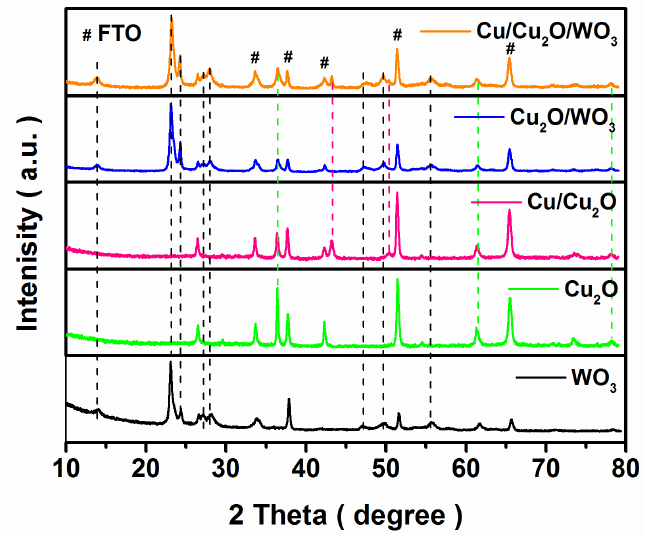
Figure 1. XRD patterns of the bare and composite samples (# sign: the characteristic peak of FTO substrate). X-ray photoelectron spectroscopy (XPS) measurements were carried out to elucidate the surface composition and chemical states of the elements. The survey XPS spectrum of the typical Cu/Cu 2 O/WO 3 sample indicated that the composite mainly consisted of W, Cu and O electrons. To gain further insight into the chemical bonding between W and other atoms in the composite, the high resolution XPS spectrum of W 4f (Figure 2a) was decon- voluted by Gaussian-Lorenzian analysis. The peaks at binding energies of 37.7 and 35.7 eV were ascribed to W (VI) state in tungsten oxide materials, while two distinct peaks at 34.5 and 36.4 eV were consistent with the values of W (V) oxidation state for all the sam- ples [42,43]. The existence of W (V) was necessary to maintain the opening structure of hexagonal WO 3 [14]. However, the area ratios of W (V) and W (VI) in the composite were higher than those of the bare WO 3 sample (Table S1) due to the electroreduction process for Cu 2 O deposition. In the high-resolution Cu 2p XPS spectrum (Figure 2b), two conspic- uous peaks were observed at binding energies of 952.3 eV for Cu (I) 2p 1/2 and 932.5 eV for Cu(I) 2p 3/2 [44]. Furthermore, the Cu and W diffraction peaks of the composite shifted slightly compared with those of pure samples, which was the reason that the intense in- teraction existed between WO 3 and Cu 2 O component in the composites, implying the for- mation of heterojunction. Cu LMM Auger spectra (Figure 2c) were further performed to explore the chemical state of the Cu element, The Auger parameter can be calculated from the equation of α ′ = E k (Auger electron) + E b (photoelectron). Here, E k is the kinetic energy, and E b is the binding energy. The Auger parameter values of the Cu (I) and Cu (0) in the Cu/Cu 2 O/WO 3 composite were determined to be 1848.7 and 1851.2 eV, respectively, which indicated the existence of Cu (I) and Cu (0) in the Cu/Cu 2 O/WO 3 sample [45,46].